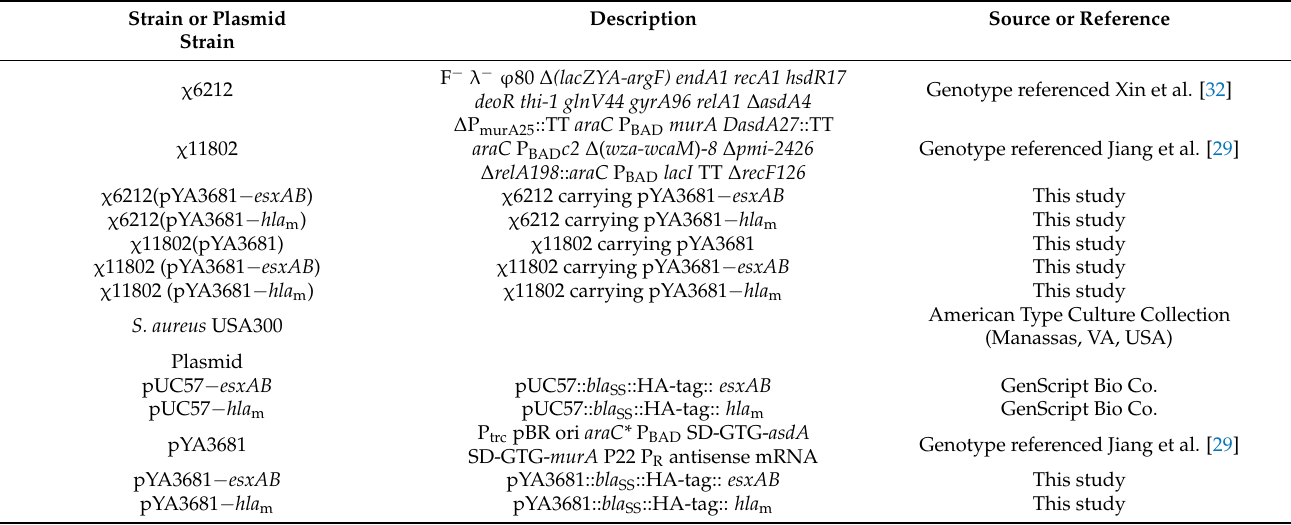
Table 1. Bacterial strains and plasmids used in this